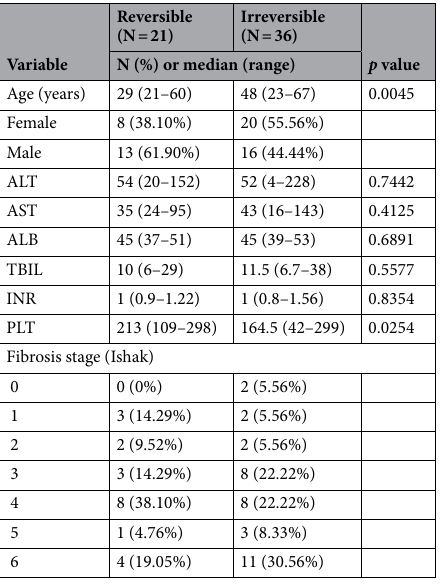
Table 2. Demographic, laboratory and pathology data for the patient cohort. ALT: alanine transferase; ALB: albumin; AST: aspartate transferase; INR: international normalized ratio; PLT: platelet; TBIL: total